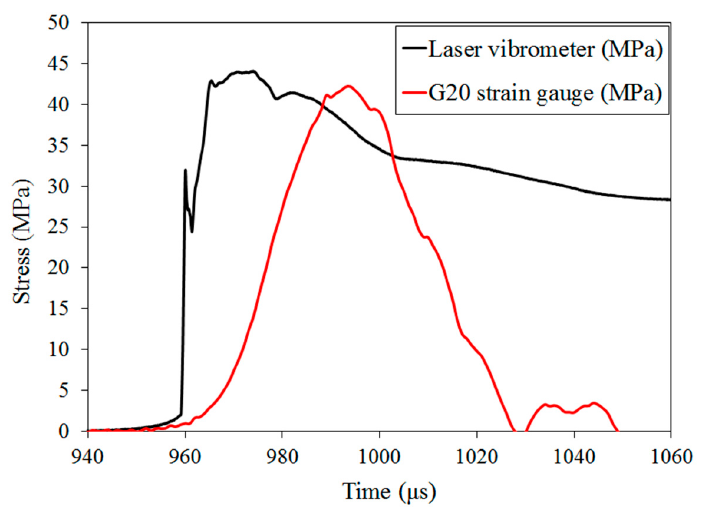
Figure 5. Nominal stress provided from the G20 strain gauge ( E . ε ( t ) ) and from the particle velocity measurement on the sample free end (1/2 ρ C 0 V ( t ) ).